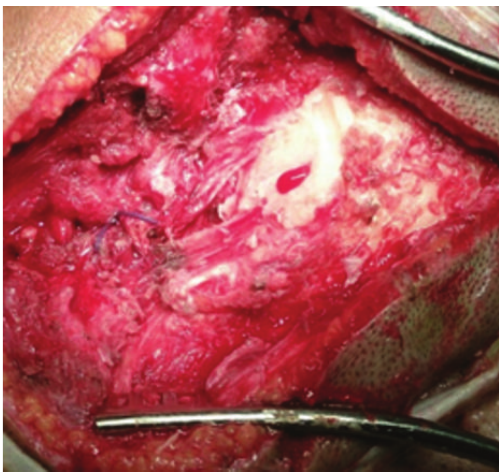
Figure 5: The calvarial base after excision of the bony